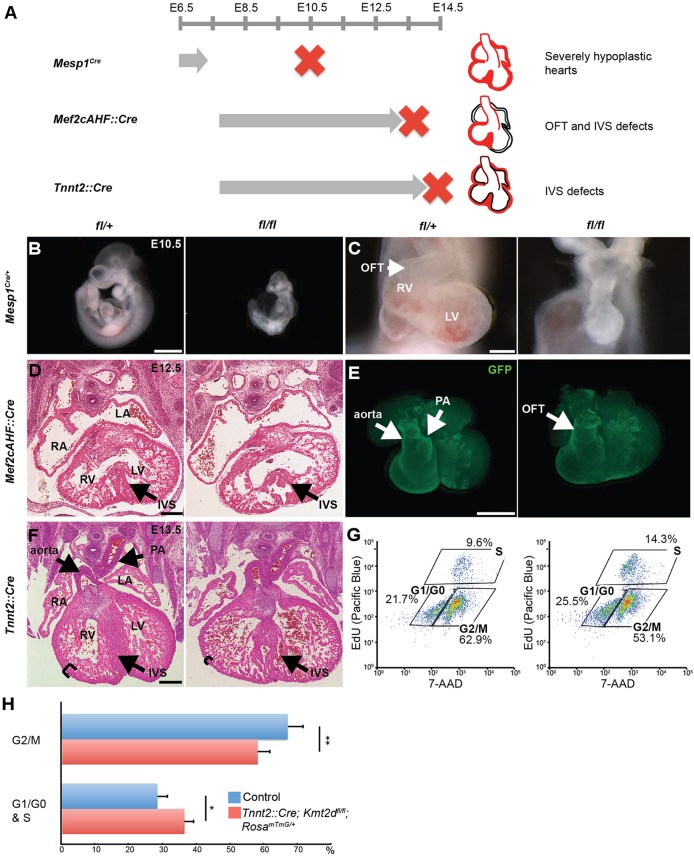
Deletion of Kmt2d in cardiac precursors and myocardium leads to embryonic lethality and cardiac defects. (A) Schematic overview of Kmt2d deletion phenotypes in mesodermal precursors, anterior heart field (AHF) precursors and cardiomyocytes. (B) E10.5 Mesp1Cre;Kmt2d fl/fl embryos show developmental delay compared with wild-type littermates. (C) E10.5 Mesp1Cre;Kmt2d fl/fl mutants show severely hypoplastic hearts. (D) E12.5 Mef2cAHF::Cre;Kmt2d fl/fl four-chamber view cardiac sections stained with H&E show a disorganized interventricular septum (arrowheads). (E) E12.5 Mef2cAHF::Cre;Kmt2d fl/fl;RosamTmG/+ hearts show defects in outflow tract septation (arrowhead). GFP reporter is expressed in Cre-positive cells. (F) E13.5 Tnnt2::Cre;Kmt2d fl/fl four-chamber view cardiac sections stained with H&E show disorganized interventricular septum (arrowheads) and thin compact myocardium (brackets) in mutants. (G) E12.5 control (WT) and Tnnt2::Cre;Kmt2d fl/fl;RosamTmG/+ (cKO) hearts were labeled with EdU for newly synthesized DNA and EdU-labeled cells were detected with Pacific Blue azide using Click chemistry. Cells were stained with 7-AAD to determine total DNA content and cell cycle distribution was determined by FACS analysis, sorting for Cre-positive cells using GFP reporter. Representative FACS plots of the Cre-positive population show an increase in the number of cells in G1/G0 and S phase and a decrease in G2/M phase in the mutant. (H) Cell cycle analysis of E12.5 control and Tnnt2::Cre;Kmt2d fl/fl;RosamTmG/+ hearts (n=4 per genotype) shows an 8.0% increase in G1/G0 and S phases (P<0.05) and an 8.8% decrease in G2/M phases in mutants (P<0.01). RV, right ventricle; LV, left ventricle; PA, pulmonary artery; OFT, outflow tract; IVS, interventricular septum. *P<0.05, **P<0.01. Error bars indicate s.d. Scale bars: 1 mm in B; 200 μm in C; 250 μm in D,F; 500 μm in E.